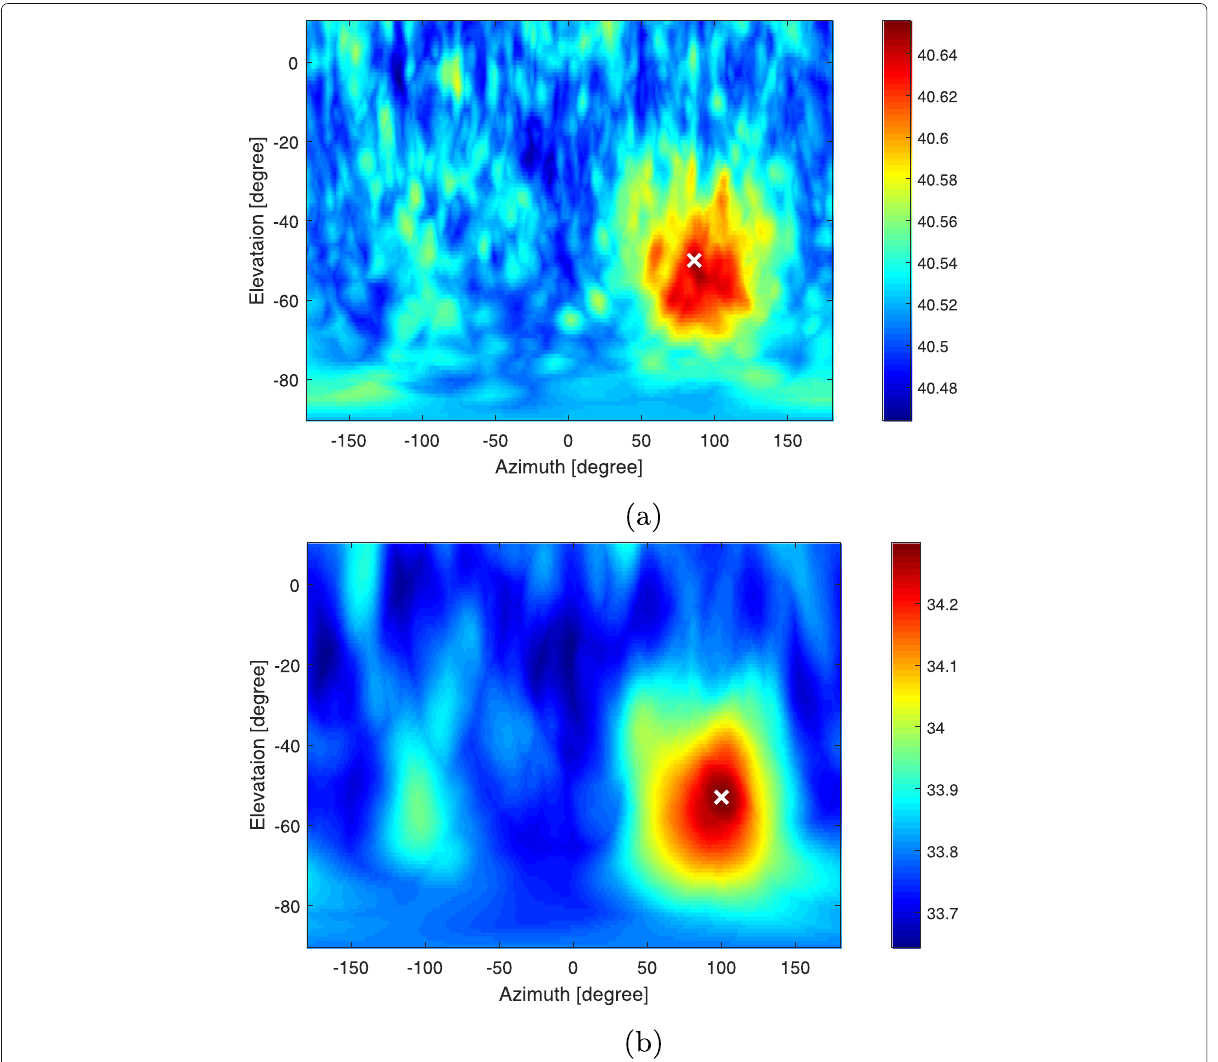
Fig.11 SNRangularspectralresponse(dB)fromSPCupflyingUAVbroadbandsoundsource(task2)case11 a w/oSNRresponsescalingand b w/SNR response scaling, using GCC-NONLIN with max aggregation. Cross ( × ) in the diagram represents the algorithm’s estimated peak response location